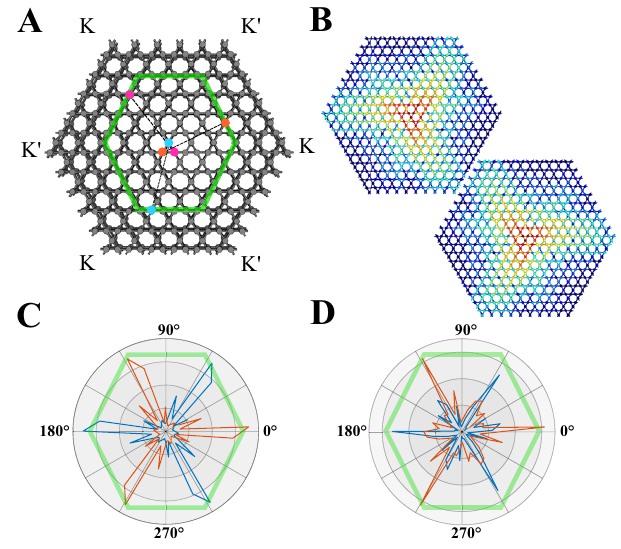
Fig. 3 | Experimental demonstration of selected acoustic mode propagation. a Map of the kagome lattice with measured path outlined in green and source located at the central blue site. Each corner of the hexagon represents the K/K ’ points of the Brillouin zone. When measuring the amplitude and phase response alongthegreenpath,weconsideredthe C 3 symmetryofthelattice:placingasource atthecentralbluesiteandmeasuringtheamplitude/phaseresponseatthebluesite on the green path is equivalent to placing the source at the central orange (magenta) site and measuring the amplitude/phase response at the orange (magenta)sitealongthegreenpath.Ateachsite n alongthegreenpathwecannow describe the full amplitude response for a circularly polarized source as a super- position of the contribution from each of the individual source sites: e A e A e A ± i ð 2 π = 3 Þ + e A ± i ð 4 π = 3 Þ . b Large scale fi rst-principles cal- n = blue , n + orange , n e magenta , n e culation of sources of different handedness placed at the center. c Angular dis- tribution of the numerically calculated amplitude response. d Experimentally measured angular distribution of the full amplitude response e A n . Orange repre- sents left-circularly polarized (LCP) superpositions and blue represents right- circularly polarized (RCP) superpositions. LCP sources propagate along the K direction while RCP sources propagate along the K ′